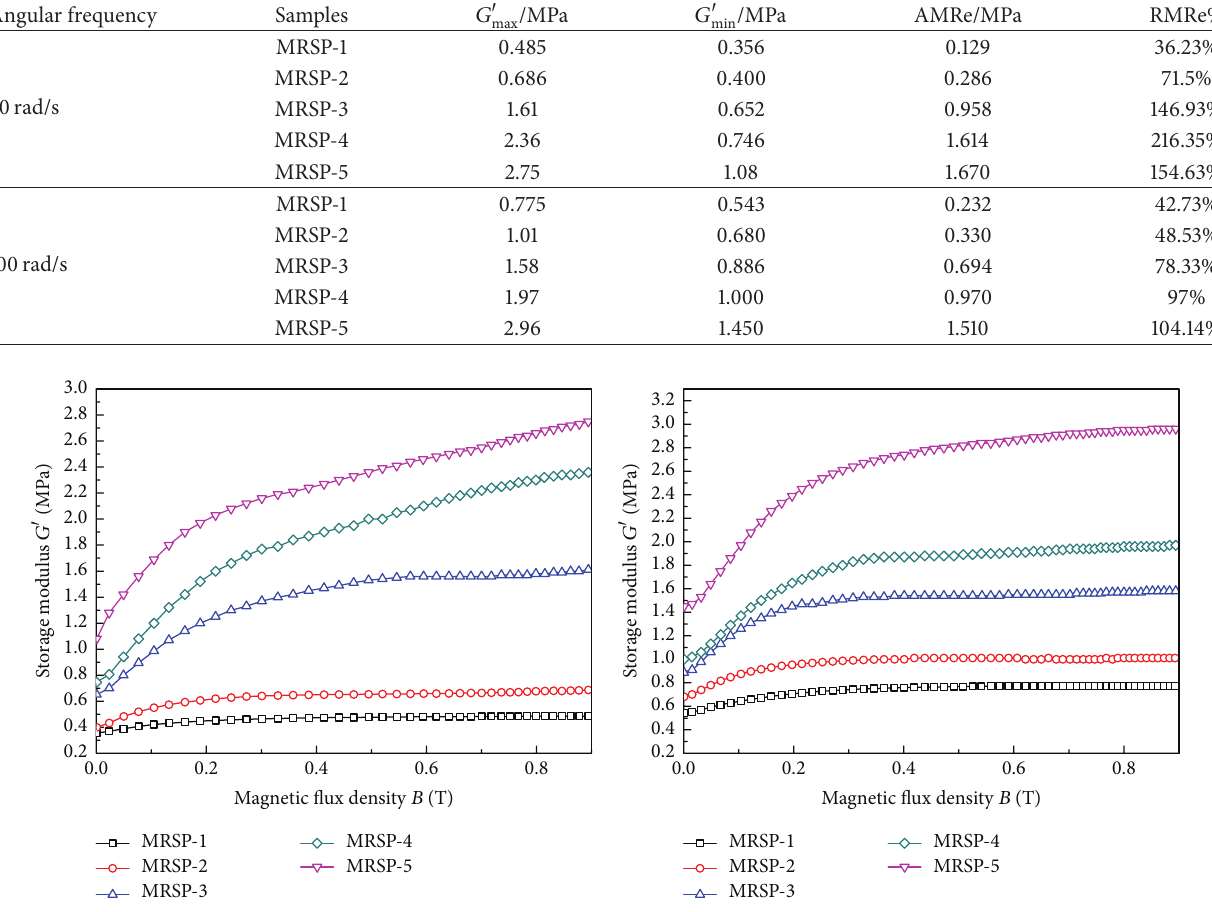
Table 6: 𝐺 󸀠 max , 𝐺 󸀠 min , AMRe, and RMRe% of MRSPs with externally applied magnetic field at different angular frequencies. Angular frequency